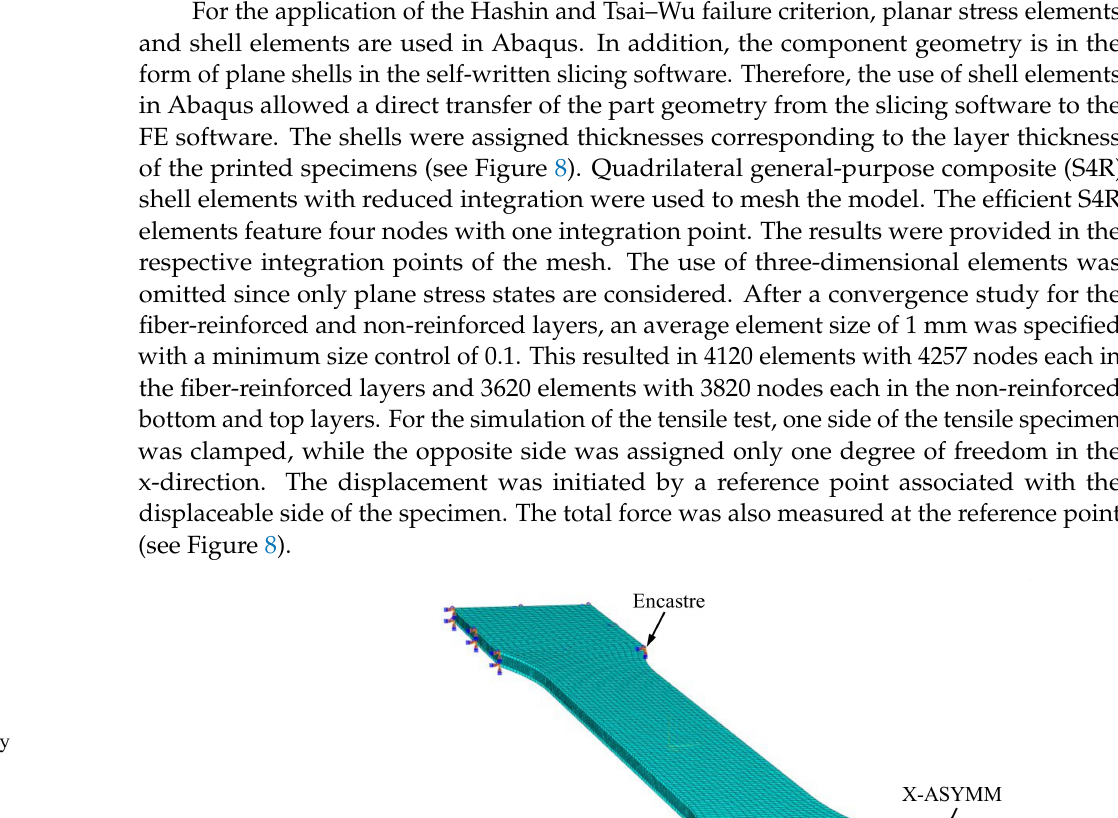
Figure 7. Approach to the creation of the FE model of a printed component with complex fiber trajectories.